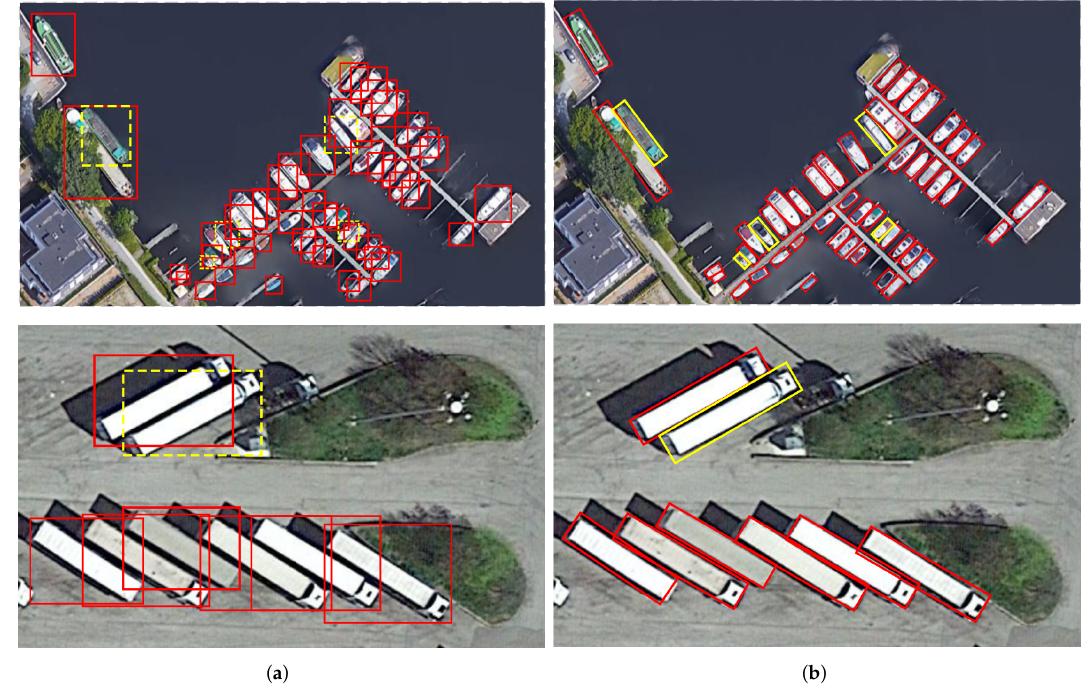
Figure 1. ( a ) HBB detection of densely-distributed and strip-like objects with large redundancy regions; objects in yellow line of dashes are prone to missed detection; ( b ) OBB detection is suitable; objects in yellow line can be detected rightly with fitting